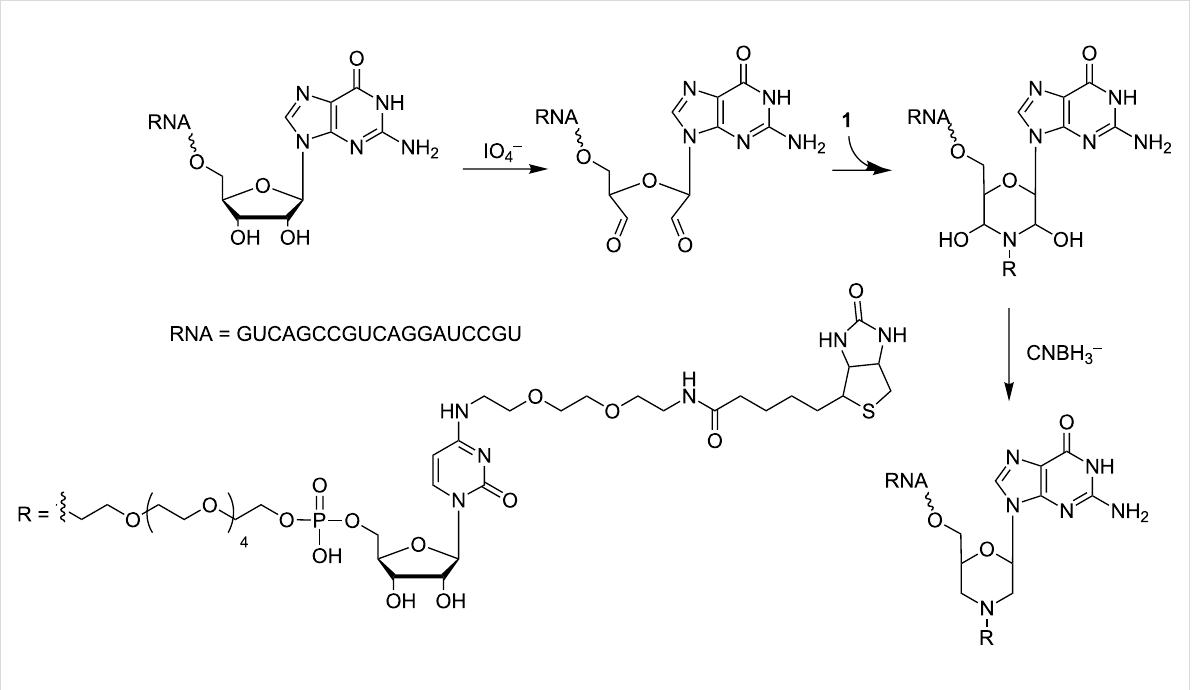
Figure 7: Reaction scheme of periodate oxidation of a 20mer model RNA followed by coupling of cytidine derivative 1 .